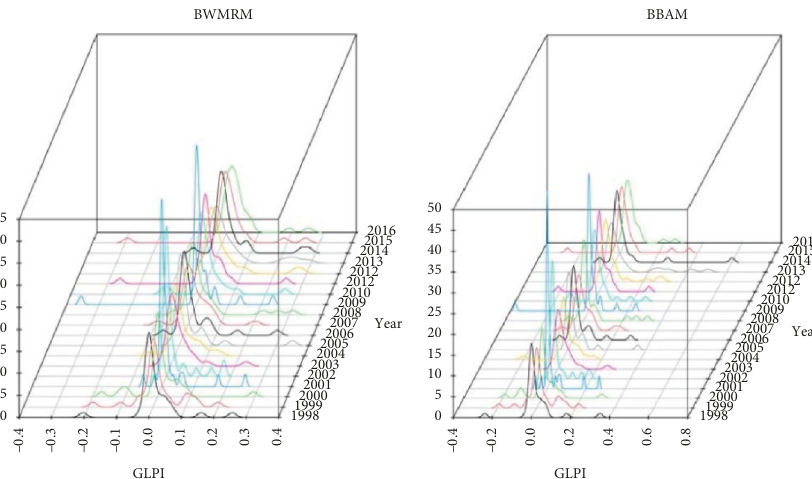
Figure 2: The dynamic distribution of kernel density estimation of GLPI in